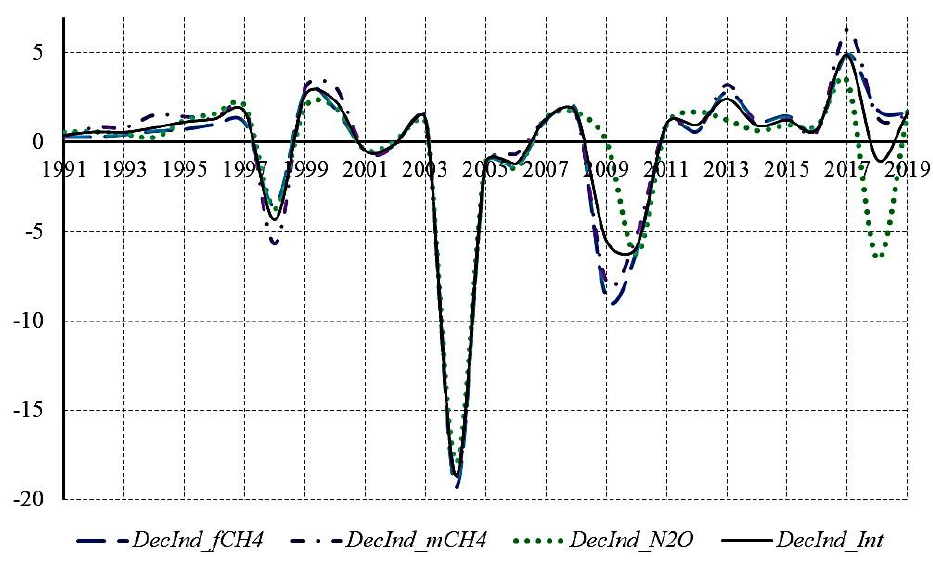
Fig. 3. Dynamics of the Decoupling Index in the cattle production sector during 1990-2019